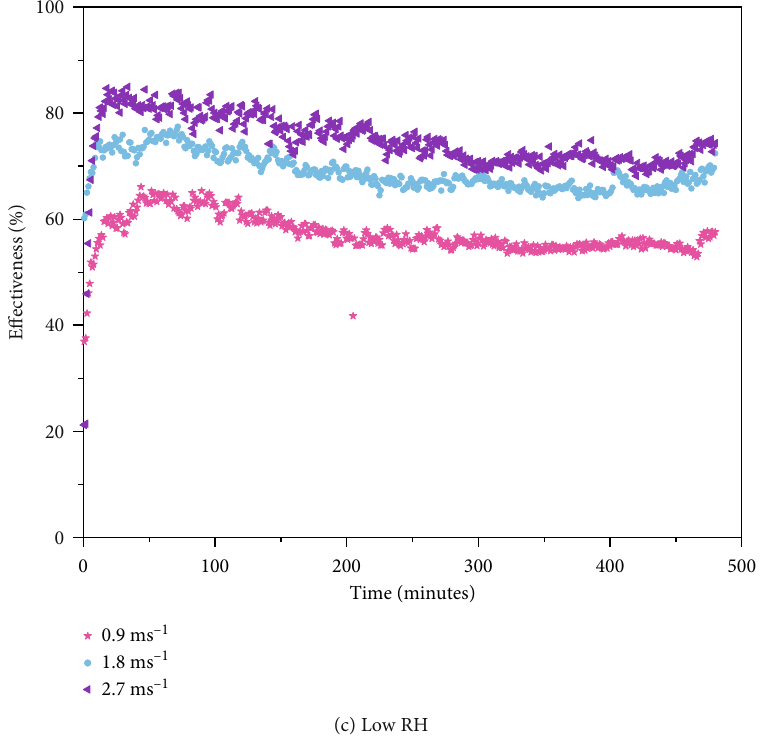
Figure 13: E ff ectiveness of the air cooler at three di ff erent velocities under three di ff erent RH conditions.